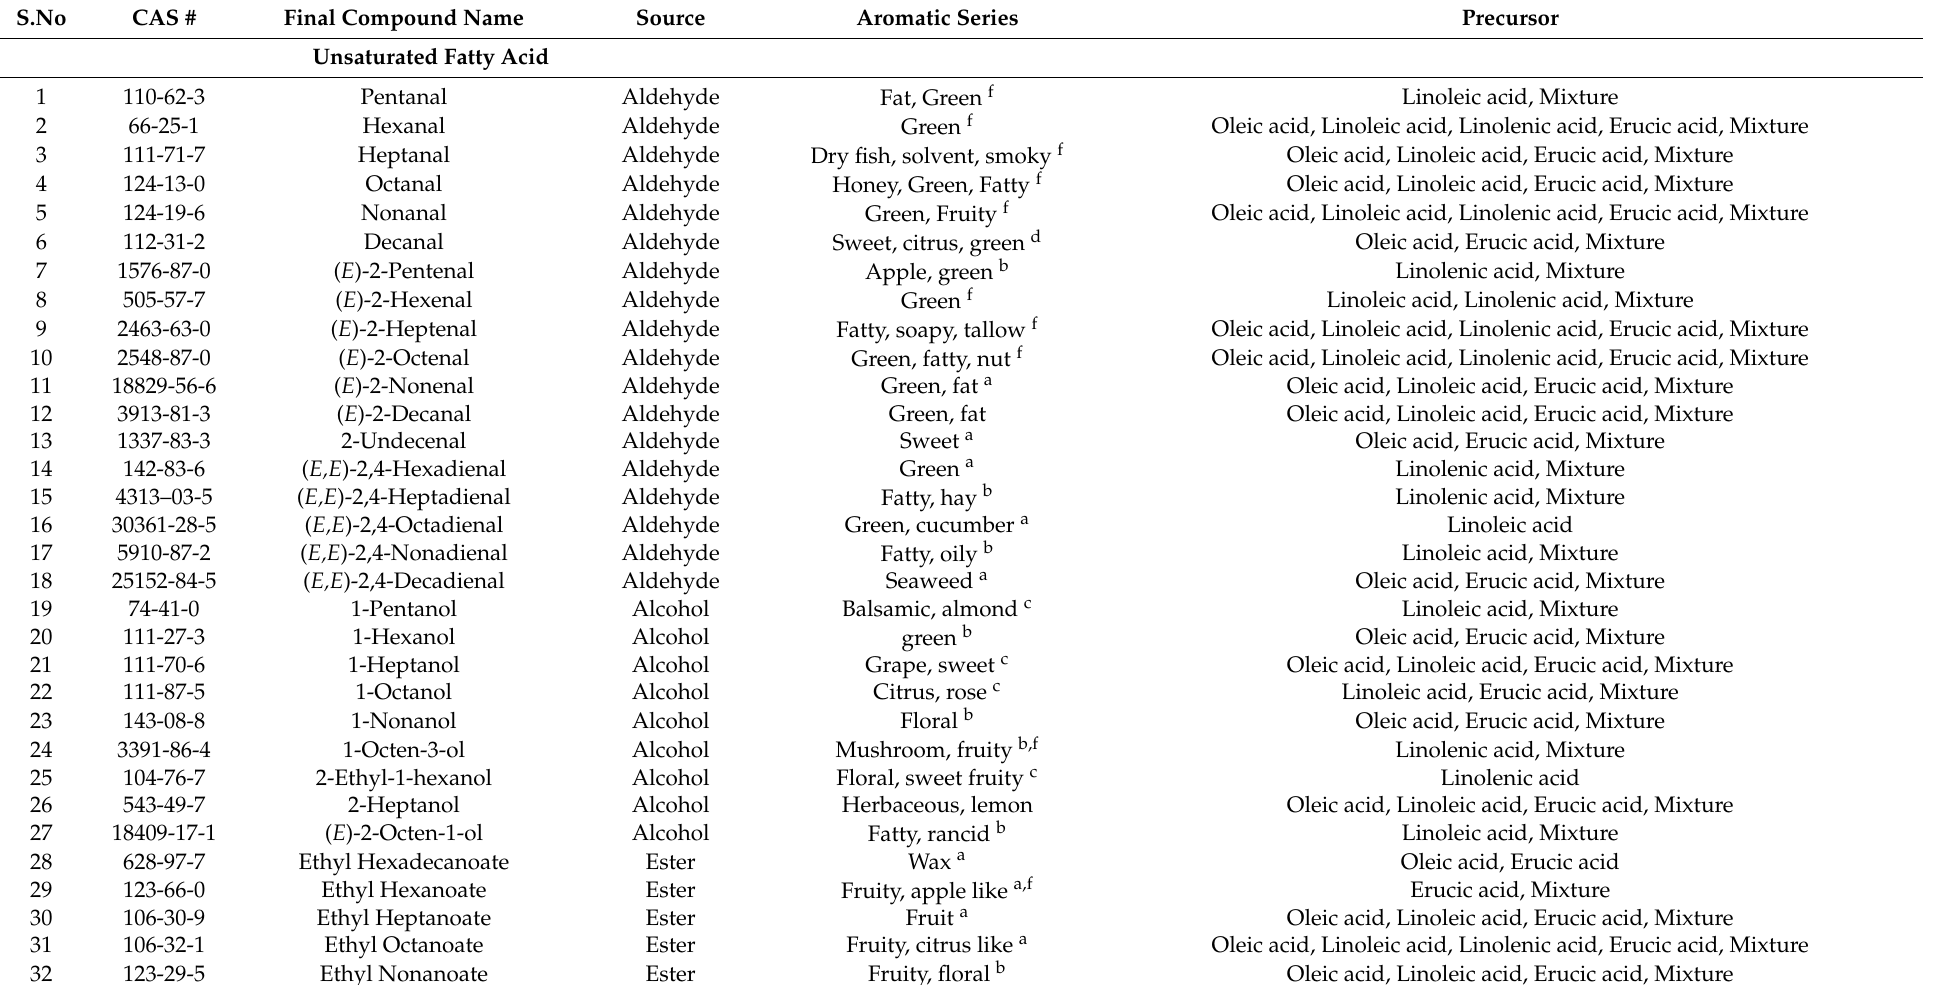
Table 3. The UFAO-derived compounds produced their respective fatty acids in raisin-like model